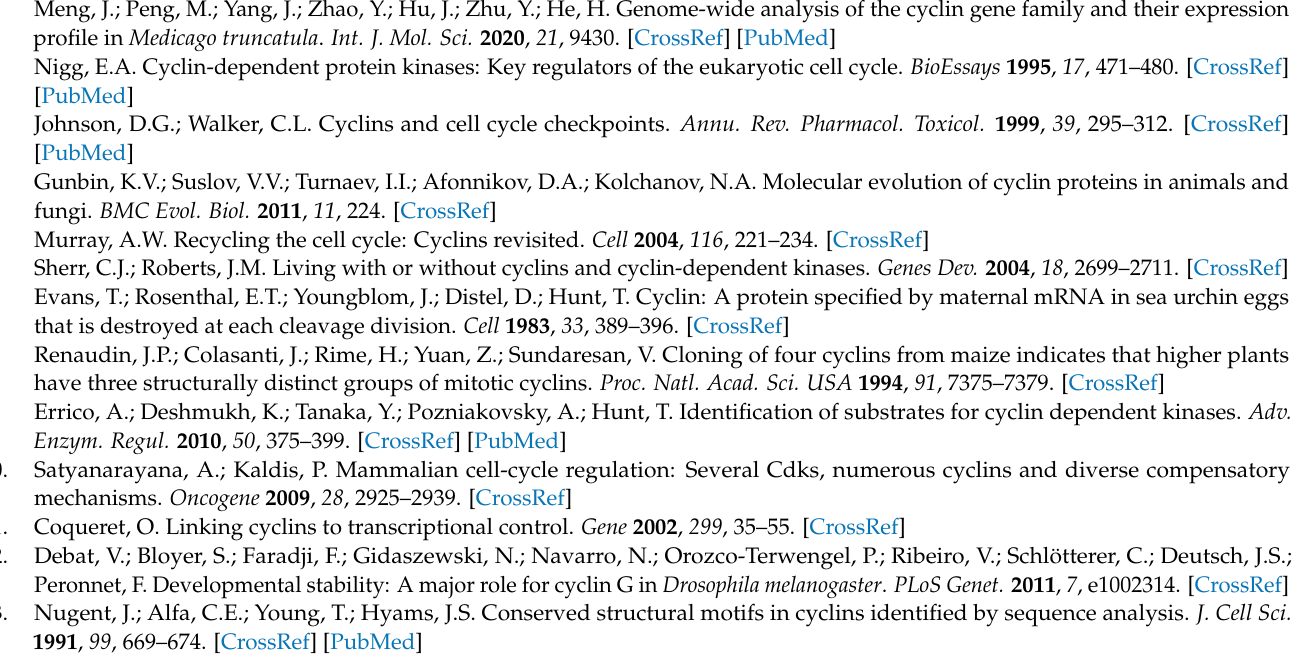
PxCyc B1 and synthesized dsRNAs; Table S1: Primer used in this study; Table S2: Protein sequences of cyclin genes of P. xylostella ; Table S3: Conserved motif details; Table S4: Details and sequences of three different species used for phylogenetic analysis; Table S5: Details of identified miRNAs targeting the different cyclin genes of P. xylostella ; Table S6: Details of transcriptomic data used to construct the